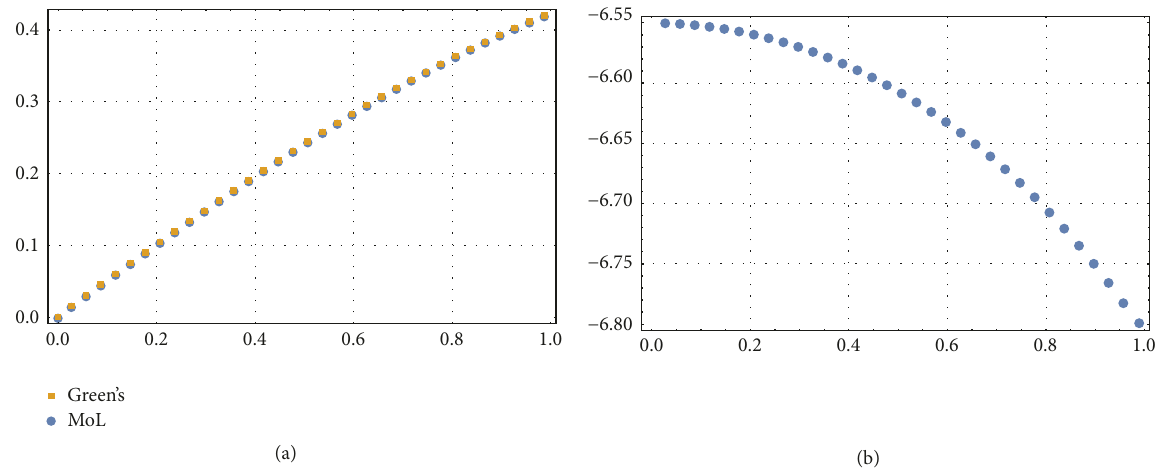
Figure 7: Discrete plot of 𝑤 and 𝑤 MoL (a) and Er (b) against 𝑡 ∈ [0,1] for 𝑓(𝑡) = 𝛿(𝑡) : hyperbolic potential. Green’s